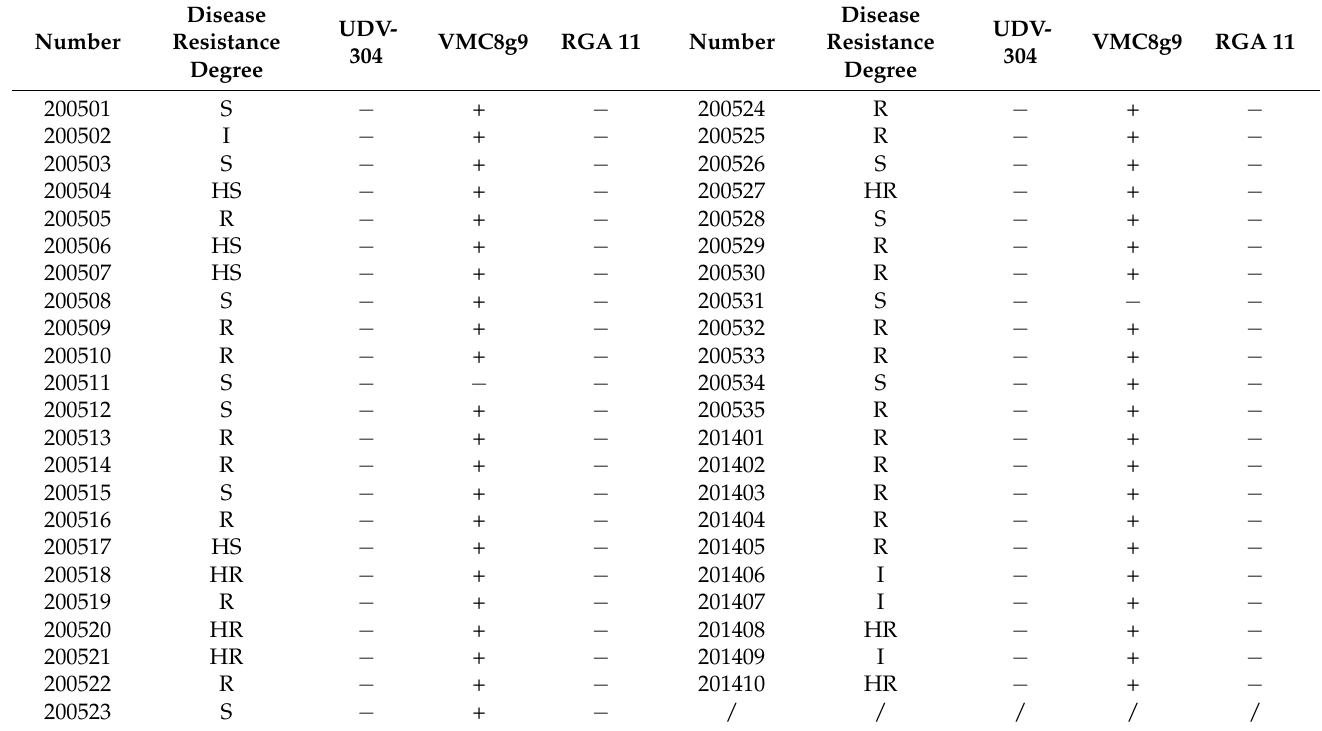
Table 7. Amplification results of two markers in combination 4.